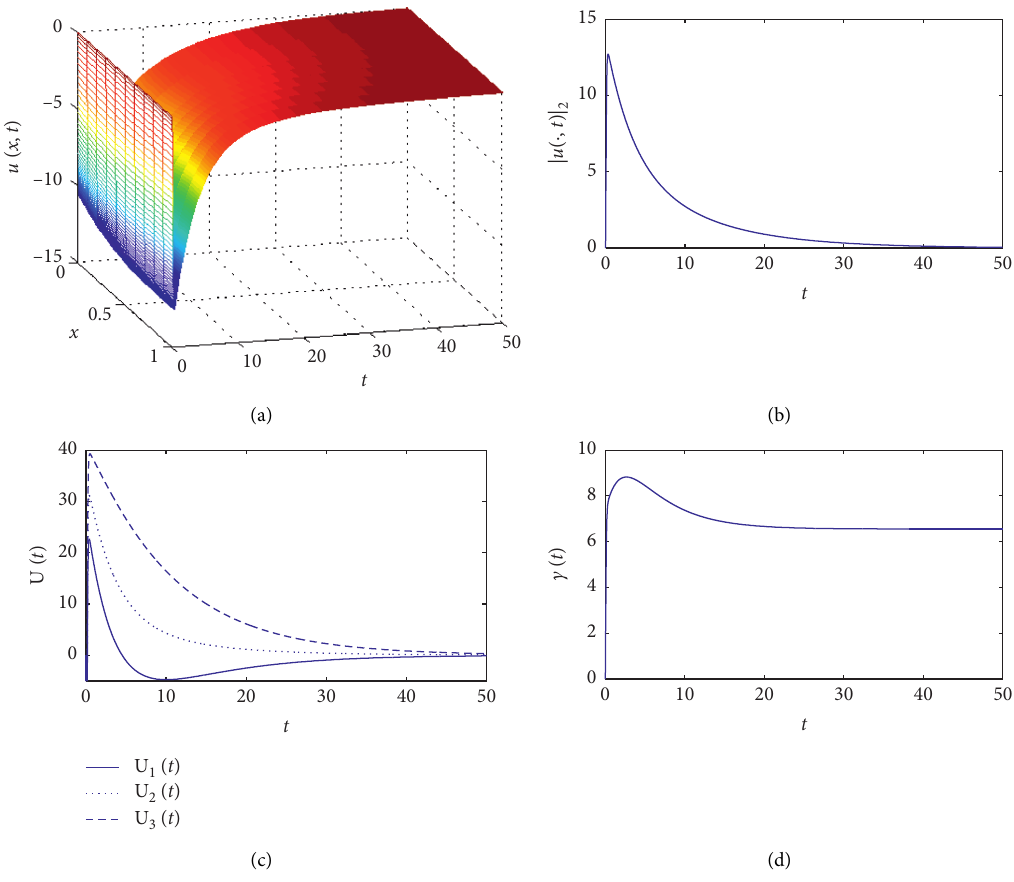
Figure 3: Closed-loop coupled DPS (18), (19), (7), and (9) with u ω ( t ) ≜ exp (− 0 . 1 t ) exp (− 0 . 3 t ) 􏼂 􏼃 , for local piecewise control and noncollocated local piecewise measurement in space. (a) Closed-loop profile of evolution of u ( z, t ) . (b) Closed-loop trajectory of | u (· , t )| compensator U ( t ) . (d) The trajectory of c ( t )